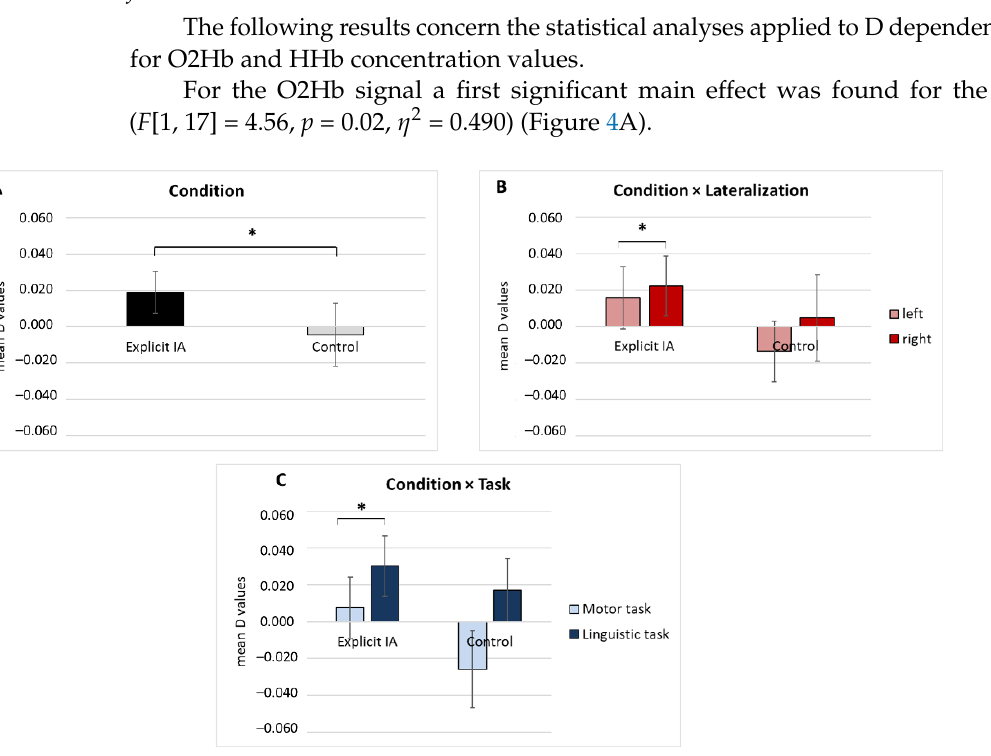
Figure 4. fNIRS hemodynamic results. ( A ) The graph displays O2Hb modulation (D values) as a function of Condition, which is significantly increased for the explicit IA compared to the control condition. ( B ) The bar chart shows significantly higher O2Hb values in the right compared to left frontal areas in the explicit IA condition. ( C ) As the bar graph shows, significantly greater mean O2Hb values were found in the linguistic than the motor task in the explicit IA condition. All data are represented as mean ± SE; all asterisks (*) mark statistically significant differences, with p ≤ 0.05.